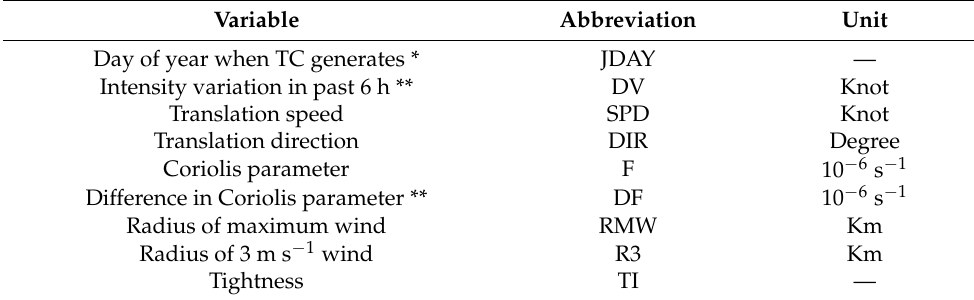
Table 3. Variables used as TC state features in the model.